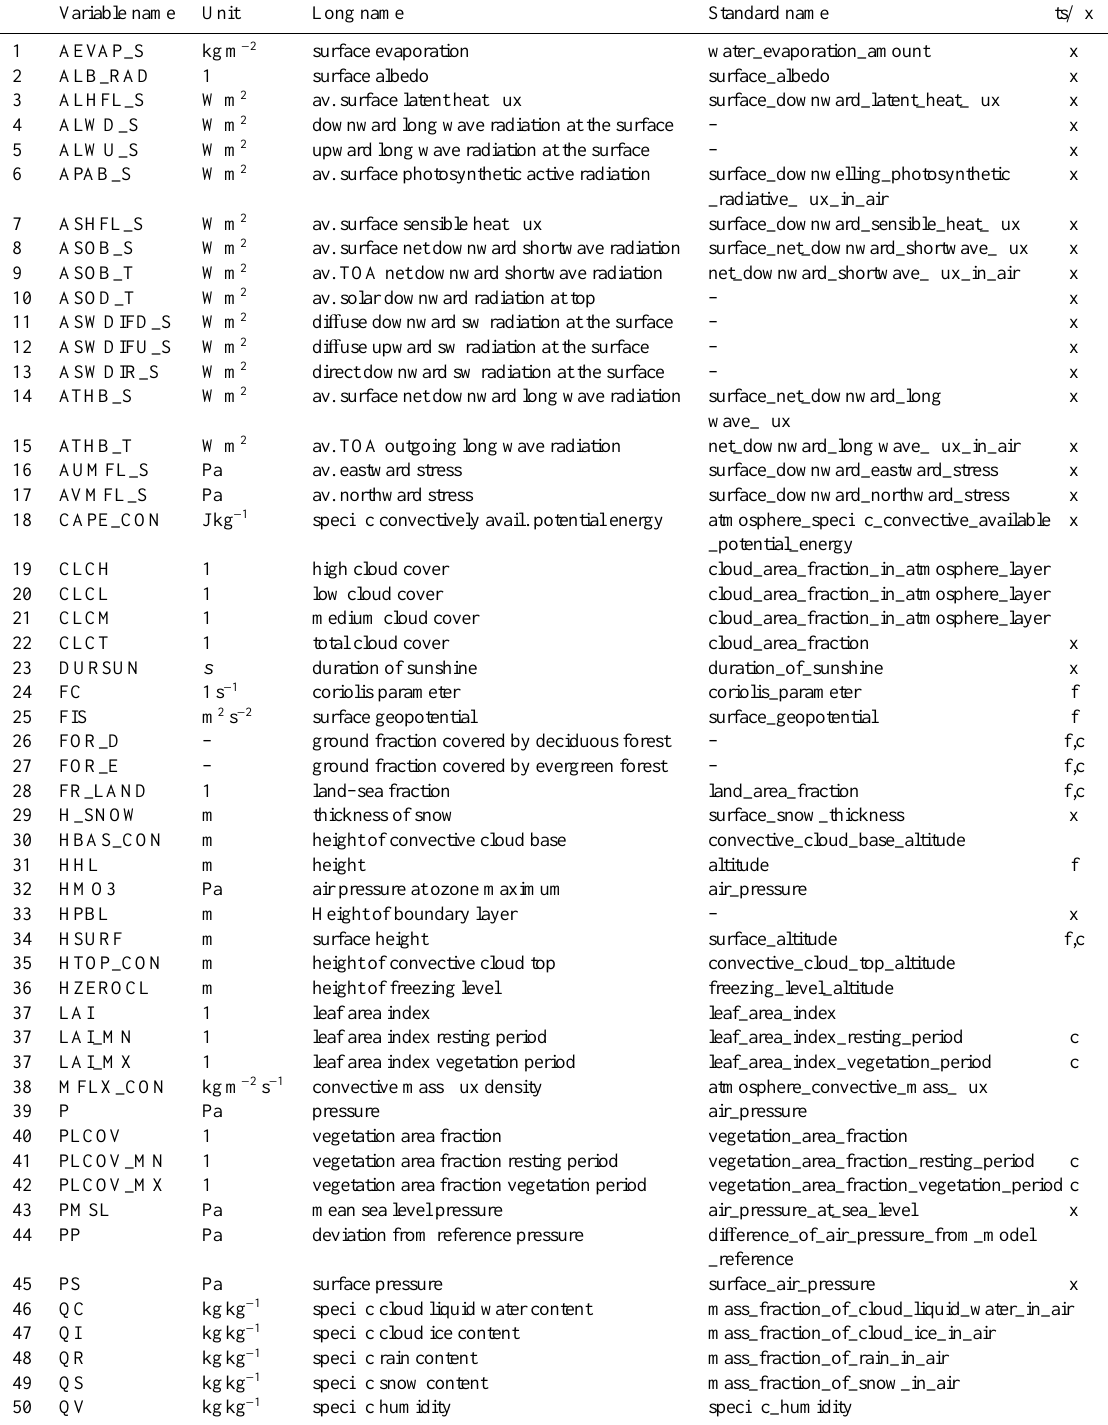
Table A1. List of output variables of coastDat2 data set. The time series published by Geyer and Rockel (2013) are marked in column “ts / fix” with a cross. Time independent variables are labeled with “f” and “c” and were merged in the files coastDat2_COSMO-CLM_fx and coastDat2_COSMO-CLM_cl, respectively. The latter are climatological CCLM input data produced by